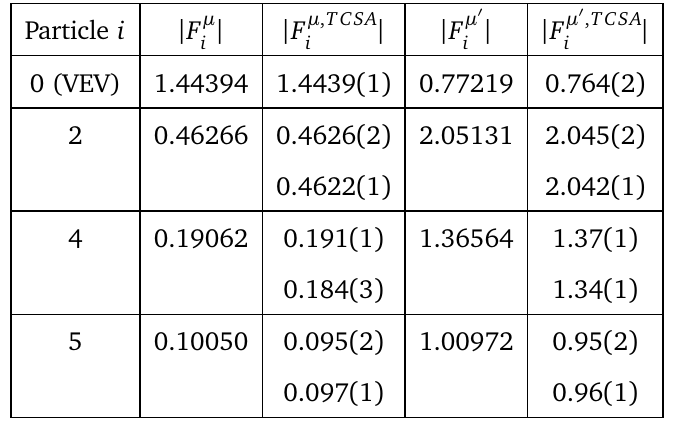
Table 6.3: Vacuum expectation values and one-particle form factors of the disor- der operators, TCSA vs. form factor bootsrap. For the one-particle matrix elements obtained from TCSA, the top number correspond to the vacuum state in the Neveu- Schwarz and the particle state in the Ramond sector, while the bottom one is obtained with the opposite choice. For the VEV, there is no such distinction. The digits in paren- theses indicate the error in the last digit of the TCSA data, which is estimated from the stability of the exponential fit under the choice of the volume window. Note that the deviations in the subleading magnetisation data are an order of magnitude worse then for the leading one, and also that TCSA estimates of matrix elements involving higher particles are generally less accurate due to truncation errors, as discussed in Appendix C.2. In particular, the apparent large deviation in the entries F σ (cid:48) ( i π ) is due to both one-particle states being high in the spectrum, which makes F σ 34 the determination of the corresponding wave functions less accurate.